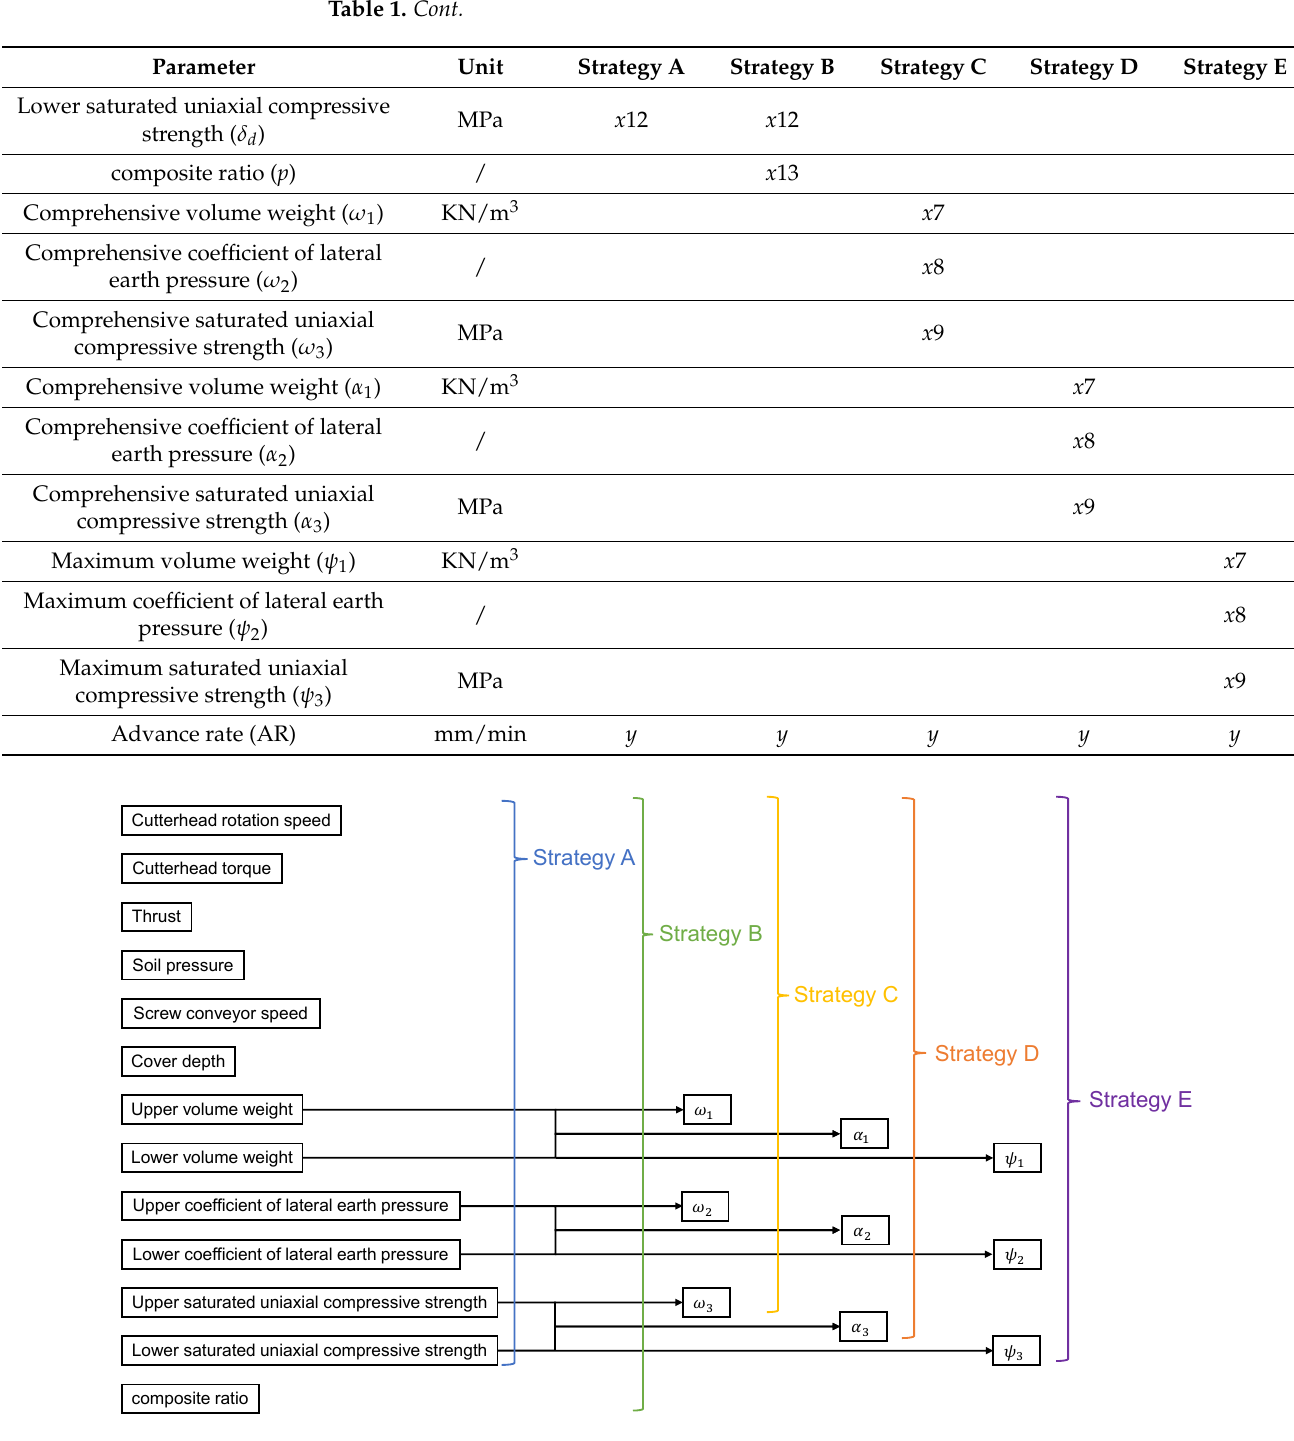
Figure 4. Input parameters of each strategy.